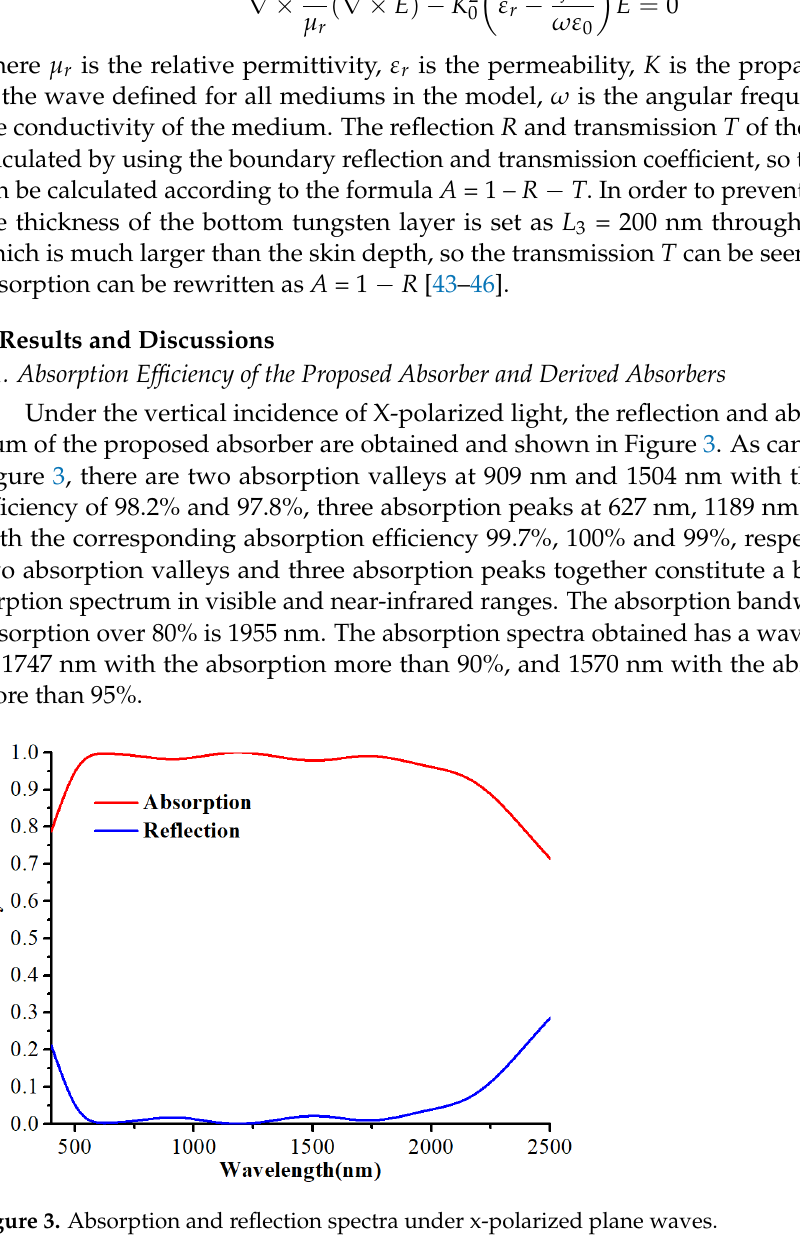
Figure 4. The absorption curve of the tungsten nanorods absorber with different RLS.